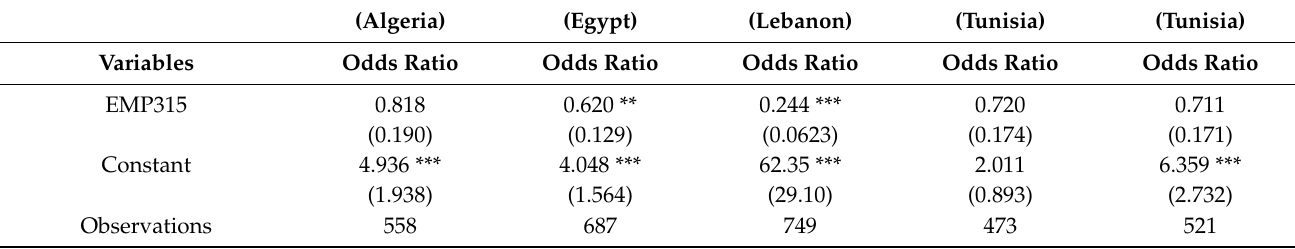
Table A9. Logistic regression on the “talk politics” index by country.